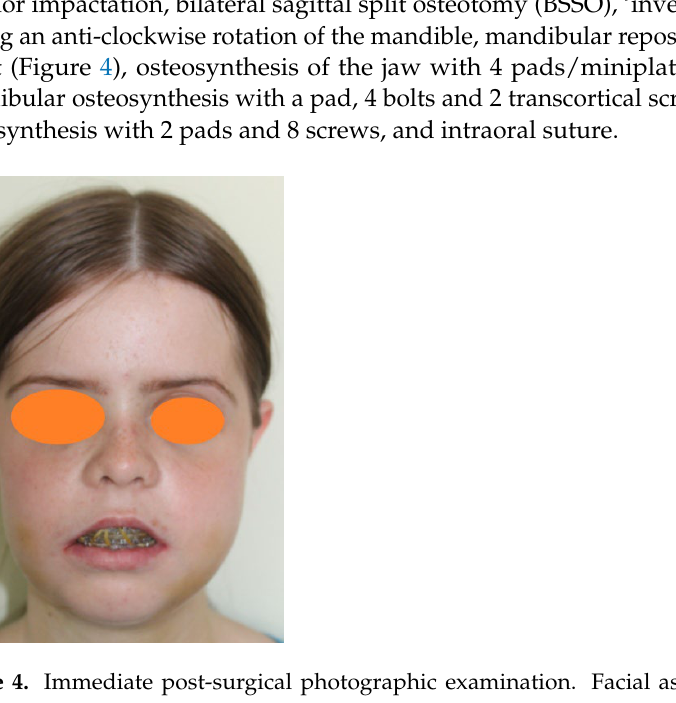
Figure 5. Cephalometric tracing using Onixceph software before ( left ) and after orthognathic sur- gery ( right ). The patient’s facial appearance at the end of the orthodontic-surgical treatment was a harmonious one, with a significant improvement of the dento-facial aesthetics, with op- timal skeletal, muscular and dental balance (a class I canine occlusal relationship and a stable therapeutic full class II molar occlusal relationship) (Figure 6).